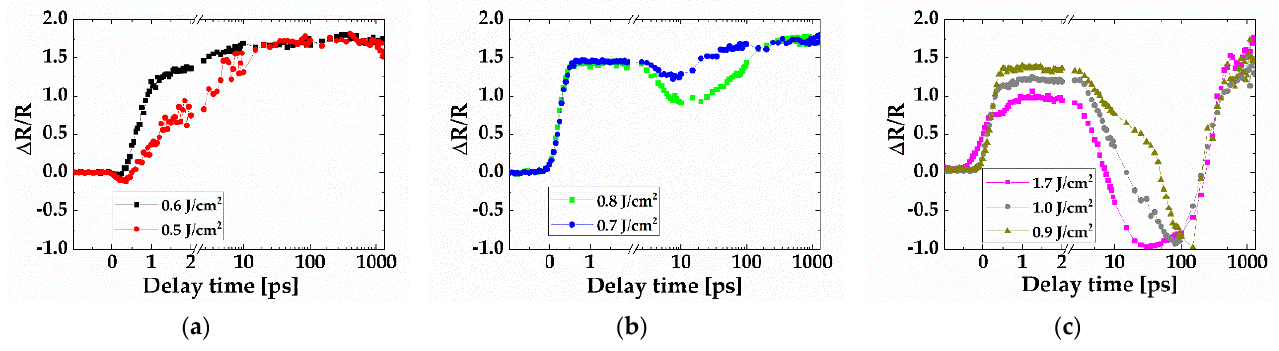
Figure 3. The temporal evolution of the surface reflectivity at increasing peak fluences ( a ) 0.5 to 0.6 J/cm 2 , ( b ) 0.7 to 0.8 J/cm 2 , and ( c ) 0.9 to 1.7 J/cm 2 . The Si ablation threshold is 0.43 J/cm 2 .